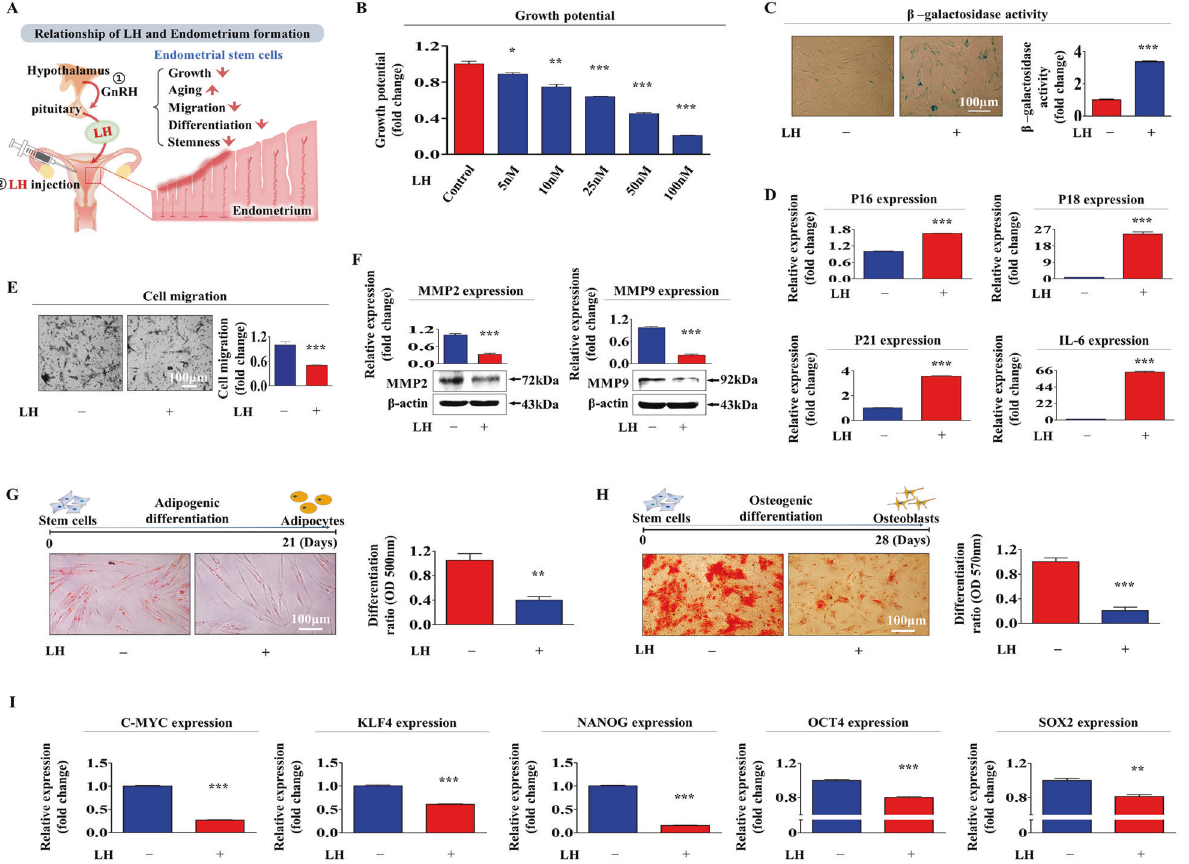
Fig. 1 LH treatment decreases self-renewability, migration, transdifferentiation abilities, pluripotency/stemness of human endometrial stem cells. We postulated that LH would inhibit tissue regeneration-associated functions in the endometrial stem cells ( A ). The inhibitory effects of LH on the self-renewability of endometrial stem cells were determined at 72 h after LH (5, 10, 25, 50, and 100 nM) treatment using MTT-based assays. Cell growth rates were estimated as the relative viability (%) of LH-treated groups compared to that in vehicle-treated groups ( B ). Effects of LH treatment on the cellular aging of endometrial stem cells were determined by evaluating the relative activities of senescence-associated β -galactosidase (SA- β -Gal) after continuous subculture with or without LH (25 nM) treatment ( C ). Effects of LH treatment on the mRNA expression levels of several cellular aging-associated genes ( p16 INK4a , p18 INK4c , p21 Cip1 , and IL-6) were also evaluated by performing qPCR ( D ). Suppressive effects of LH on the migration potential of endometrial stem cells were assessed after LH treatment (25 nM) for 72 h using transwell assays. A clear reduction in the migration ability across the transwell membranes (8.0 μ m pores) was observed following LH treatment ( E ). Effects of LH treatment on MMP-2 and MMP-9 expression levels measured using western blotting ( F ). The suppressive effects of LH (25 nM) on in vitro differentiation abilities of endometrial stem cells into adipocytes ( G ) and osteoblasts ( H ) were evaluated by performing oil red O staining and alizarin red S staining, respectively, after 2 weeks of differentiation. Suppressive effects of LH (25 nM) on the expression of various multipotent capacity-related factors ( C-MYC , KLF4 , NANOG , OCT4 , and SOX2 ) were evaluated by performing qPCR ( I ). β -actin was used as an internal control to normalize protein expression. PPIA was used as an internal control to normalize mRNA expression for qPCR analysis. All experiments were performed in triplicates. Data are presented as mean ± standard deviation (SD). * p < 0.05; ** p < 0.005; and *** p < 0.001 (two-sample t